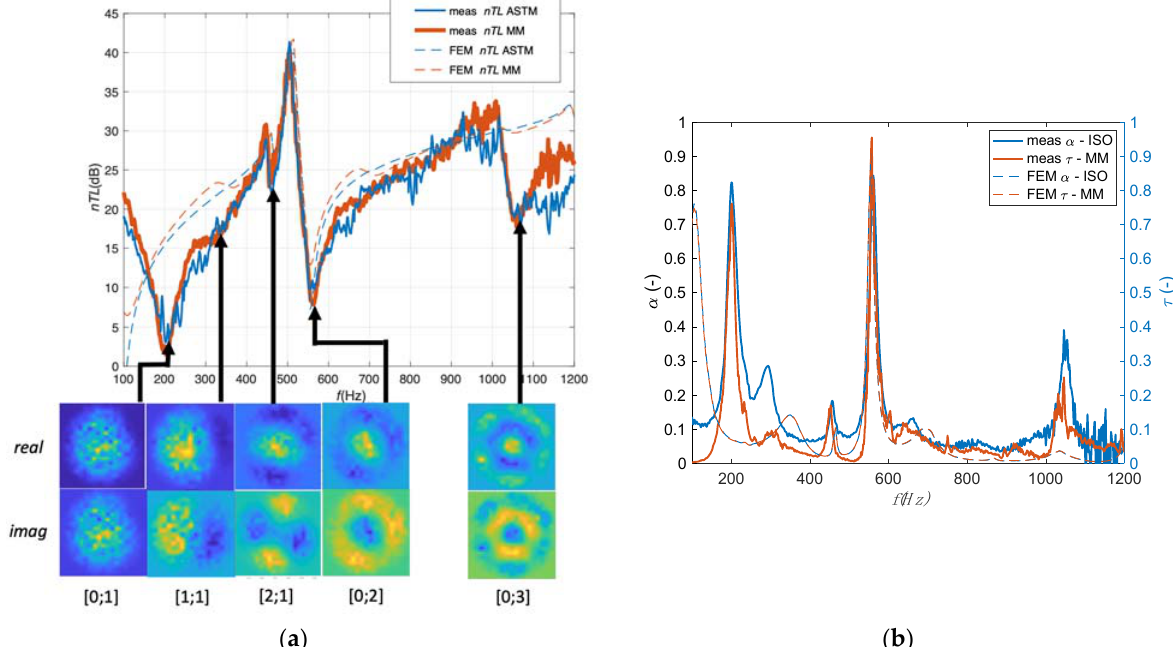
Figure 11 . ( a ) Sound transmission loss spectra of the single layer 0.5 mm PTFE membrane. ( b ) Measured sound absorption and transmission coefficient s of the single layer 0.5 mm PTFE membrane. Abbreviation describing the measurements based on: ASTM—ASTM E261109; MM—mobility based method; ISO-ISO 10534-2.